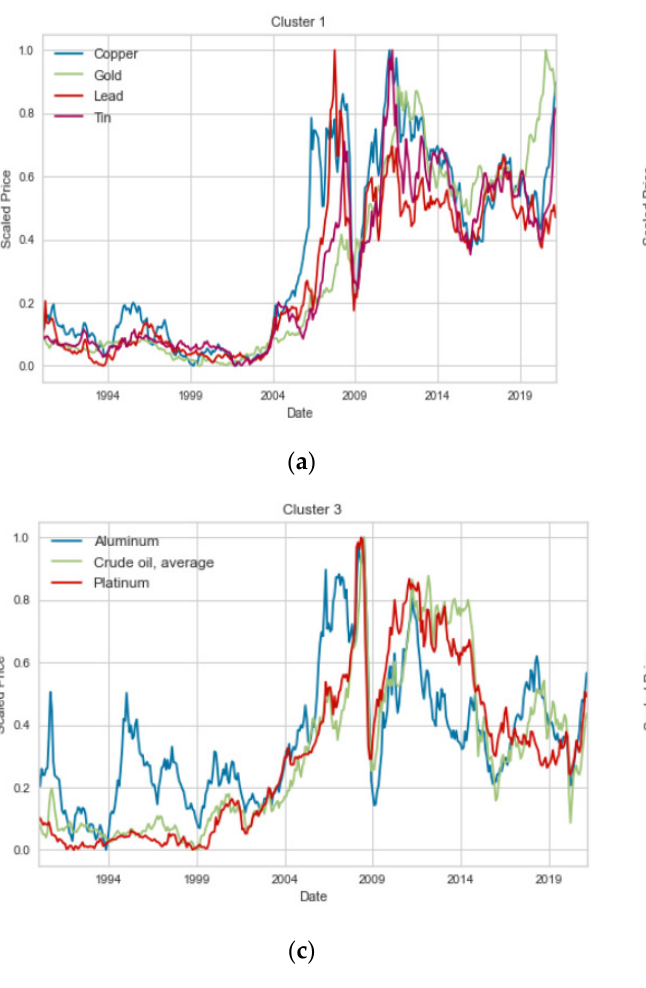
Figure 3. Final clusters of the min–max scaled time series: ( a ) Cluster 1 (copper, gold, lead, tin); ( b ) Cluster 2 (coal, iron ore, silver, zinc); ( c ) Cluster 3 (aluminum, crude oil, platinum); ( d ) Cluster 4 (nickel, uranium).